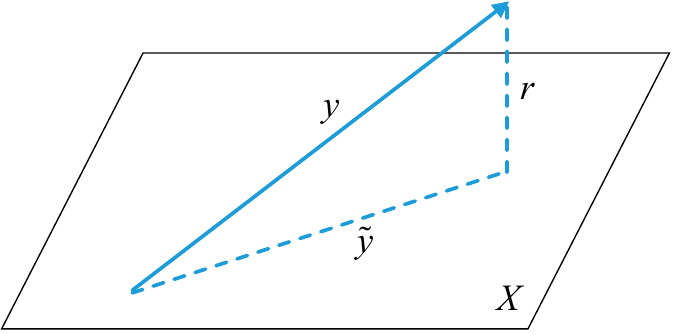
Figure 1. Schematic diagram of the linear recognition framework.